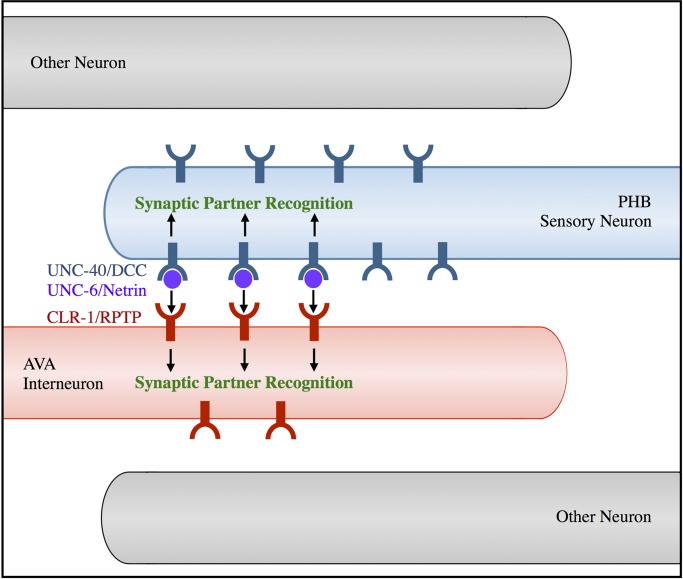
CLR-1/RPTP acts in the UNC-6/Netrin and UNC-40/DCC pathway to direct SPR.In this model, limiting amounts of UNC-6/Netrin secreted from AVA interneurons bind UNC-40/DCC expressed in PHB neurons. CLR-1/RPTP expressed in AVA neurons acts genetically downstream of UNC-6/Netrin in the SPR pathway, and its extracellular domain is required for full SPR function, suggesting that it may interact with UNC-6/Netrin, UNC-40/DCC, or another unidentified ligand or receptor. The requirement of CLR-1/RPTP’s phosphatase domain for rescue indicates that phosphatase activity is also required for its function in SPR.